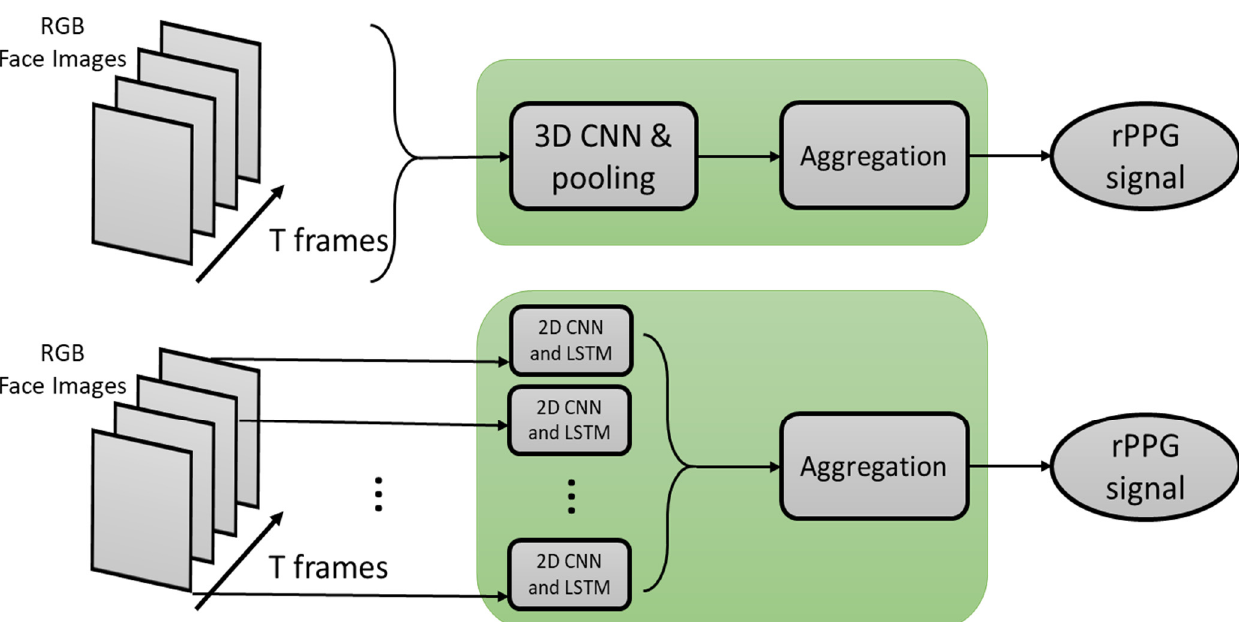
Figure 12. Architecture of PhysNet.